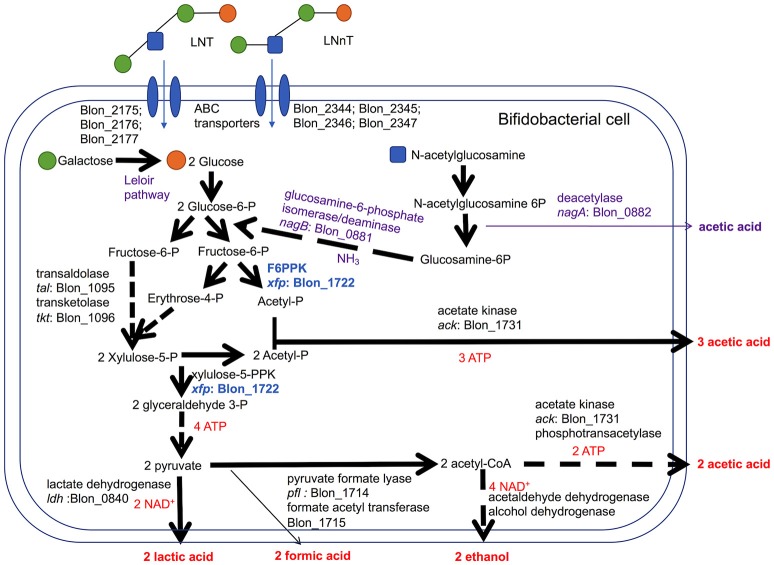
Bifidobacterium longum subsp. infantis metabolic pathways for utilization of lacto-N-tetraose (LNT) and lacto-N-neotetraose (LNnT) and their constituent monosaccharides. LNT and LNnT translocate through the cell membrane facilitated by ABC transporters. Intracellular glycosyl hydrolases process HMO into constituent monosaccharides to enter the central fermentative pathway. This pathway involves the characteristic fructose-6-phosphate phosphoketolase (F6PPK) activity denoted in blue. Genes encoding intracellular metabolic enzymes are depicted next to arrows according to their locus tag in the ATCC 15697 genome. Solid arrows are direct conversions with dashed arrows depicting the sequential actions of multiple enzymes. Predicted catabolic operations that feed into the F6PPK pathway and their corresponding products are denoted as purple. Stoichiometric coefficients of secreted metabolites, ATP, and NAD+ produced during metabolism are labeled in red. Experimental observations depicted in Figures 1, 2 including stoichiometry are incorporated.